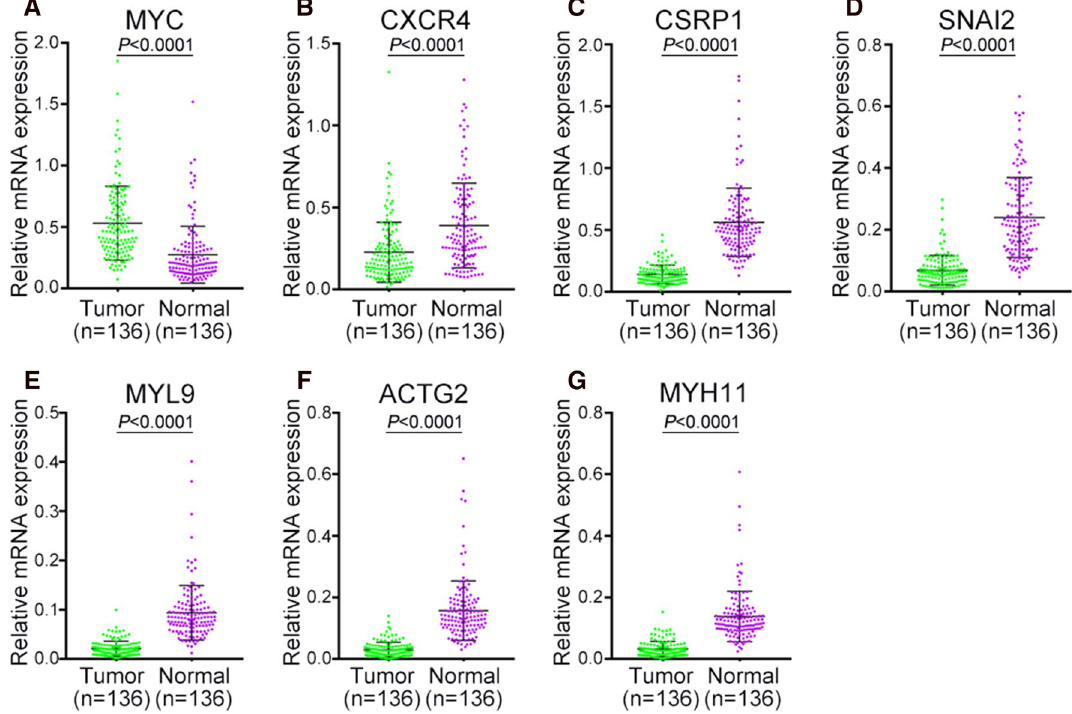
Fig. 8 The expression of hub gene in Chinese PCa patients. A MYC , B CXCR4 , C CSRP1 , D SNAI2 , E MYL9 , F ACTG2 , G